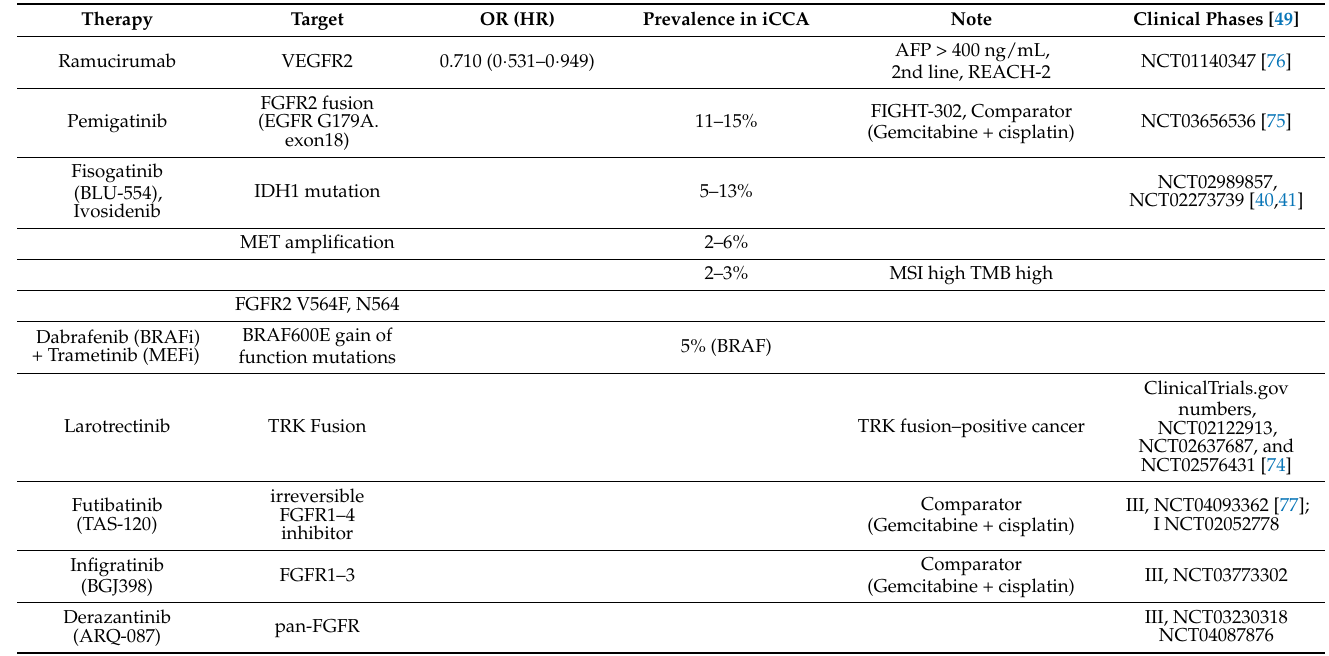
Table 2. Therapeutic targets for iCCA